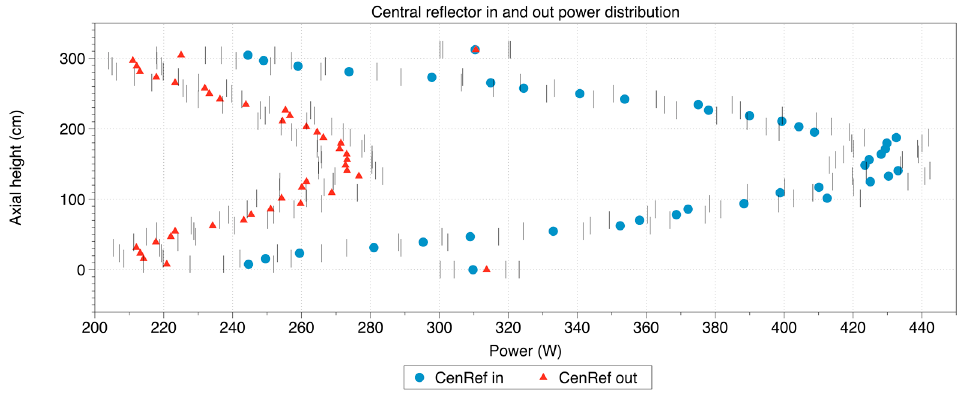
Figure 11. Axial power distribution in the monitored central pin.